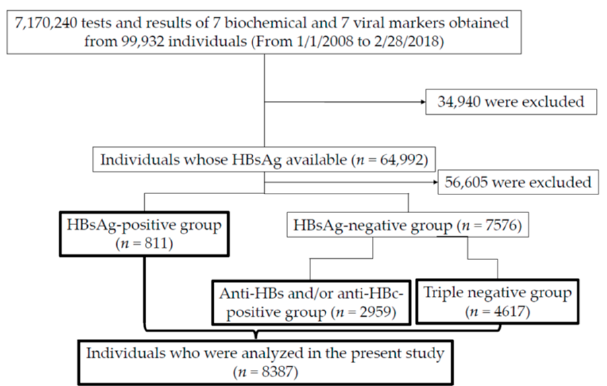
Figure 1. Flowchart demonstrating the inclusion individuals and 3 groups (HBsAg-positive, neg- ative but positive for anti-HBs/anti-HBc and triple-negative groups) in the present study. In the HBsAg-positive, negative but positive for anti-HBs/anti-HBc and triple-negative groups, blood sampling were performed at 20.3 times/person ( n = 16,489), 22.4 times/person ( n = 66,388) and 30.2 times/person ( n = 139,302), respectively. HBsAg, HBV surface antigen; anti-HBs, anti-HBs antibody; anti-HBc, anti-HBV core antibody; triple-negative group, group including individuals negative for HBsAg, anti-HBs or